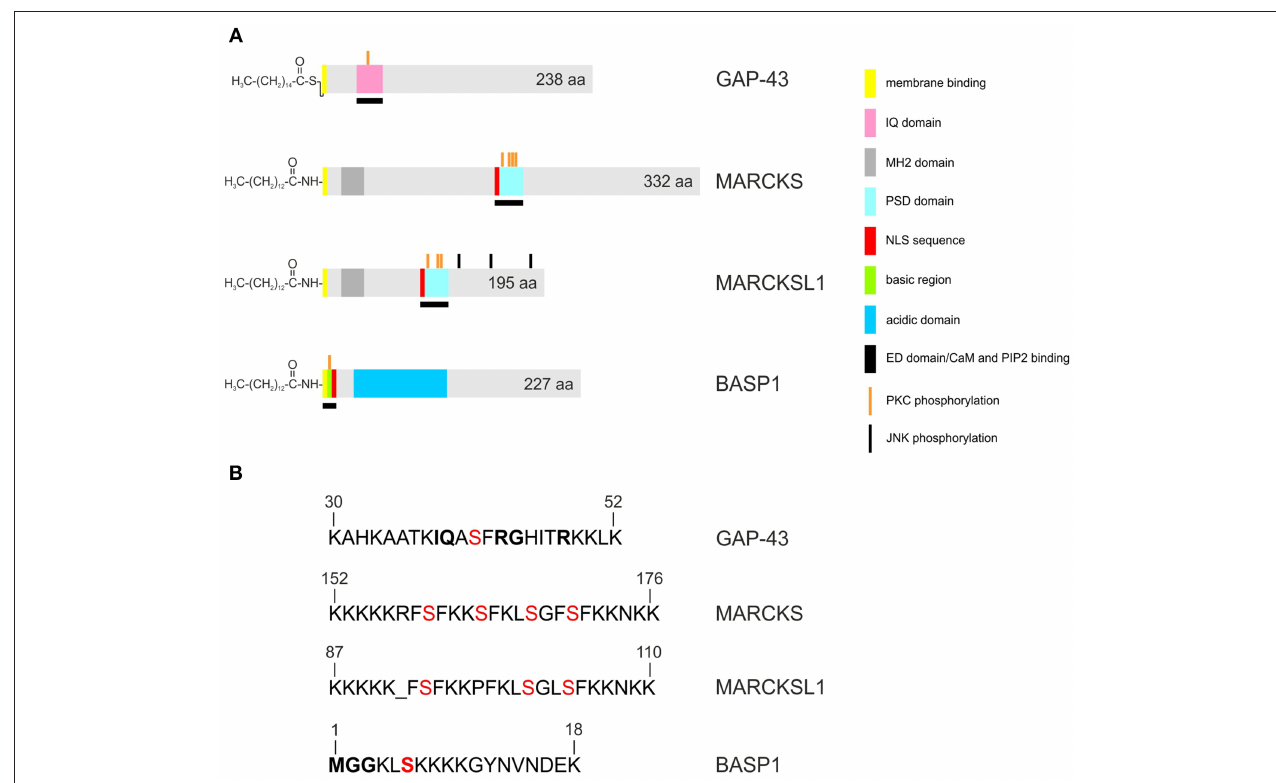
FIGURE 1 | Structures of the human GAP43, MARCKS, MARCKSL1, and BASP1 proteins. Accession numbers: P17677 (GAP43), NP_002347 (MARCKS), NP_075385 (MARCKSL1), NP_001258535 (BASP1). A larger 274-amino acid isoform of human GAP43 exists (accession no. NP_001123536) (A) Proteins are depicted as gray bars with the indicated motifs, domains and phosphorylation sites. GAP43 is palmitoylated, and MARCKS, MARCKSL1, BASP1, are myristoylated at the N-termini. (B) Primary structures of the basic effector domains. Serine residues phosphorylated by protein kinase C (PKC) are in red. Conserved residues in the IQ domain of GAP43 or in the myristoylation motif of BASP1 are in